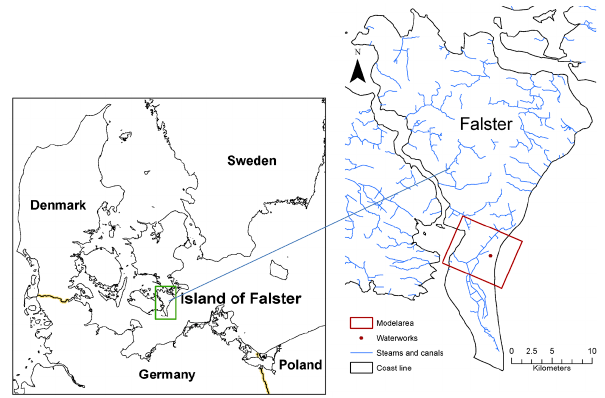
Fig. 1. Location of study area in the western Baltic